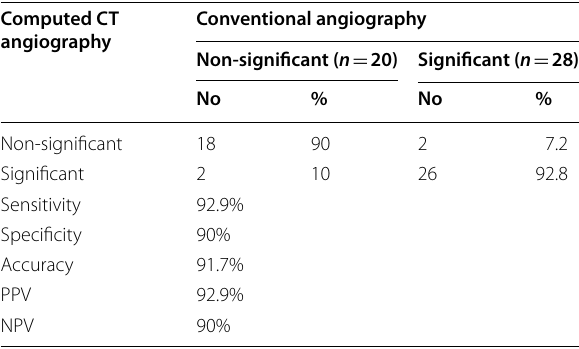
Table 4 Comparison between the Computed Tomography (CT) coronary angiography by using (CAD-RADS) and the conventional coronary angiography in all patients (per-patient analysis)